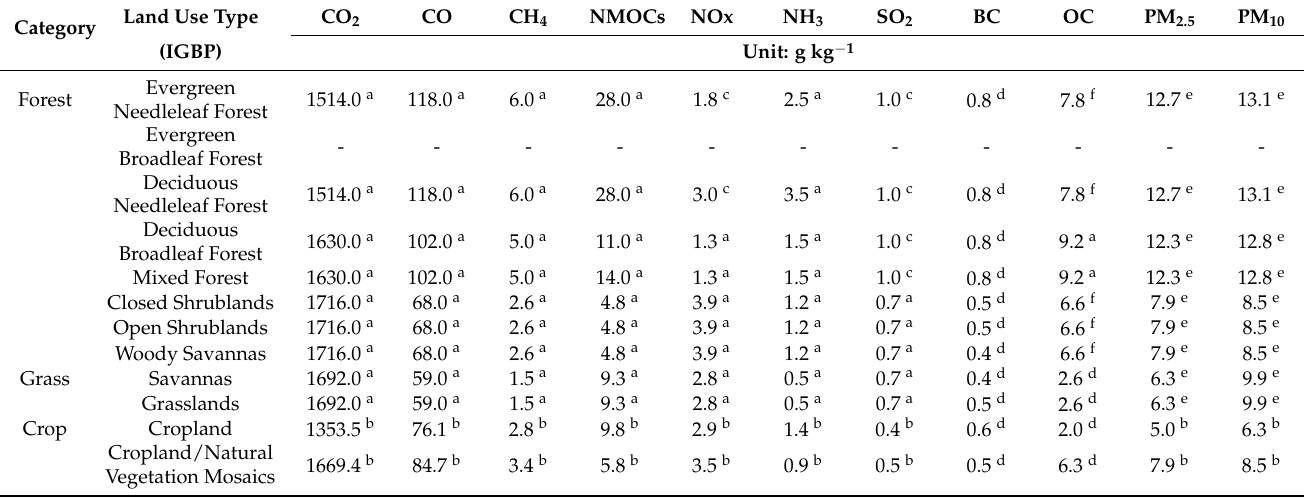
Table 2. Selected emission factors for each kind of land use type in g gas species per kg dry matter burned. (Unit: g kg − 1 ).